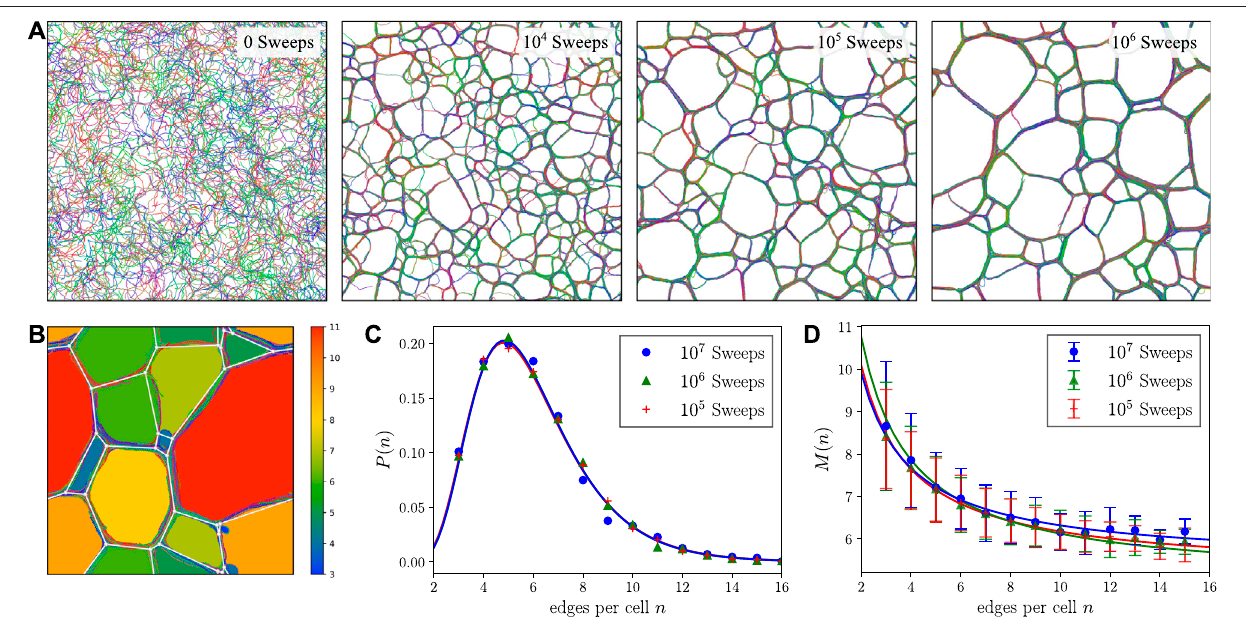
FIGURE 8 | (A) A series of snapshots (after 0, 10 4 , 10 5 , 10 6 sweeps; in a sweep, each sphere is moved once on average); demonstrating coarsening. The snapshots are taken from a simulation of M (cid:2) 1000 polymers à N (cid:2) 100 beads in a 400 σ × 400 σ × 10 σ simulation box. The simulation is performed with the following parameters:bendingconstant κ (cid:2) 30 k B T σ ,springconstant k (cid:2) 100 k B T / σ 2 andrestlength b 0 (cid:2) σ ,potentialstrength g (cid:2) 0 . 7 k B T andrange d (cid:2) 0 . 4 σ .Arandomcoloris assigned to each polymer for clarity (B) Example of a simple graph representation (white balls and bonds) as overlay over a network snapshot generated by an automatedproceduretoidentifyvertices(whiteballs)andedges(whitebonds)ofthebundlenetwork.Thecolorofcellscodesforthenumberofenclosingedges.Alldata in Figs. C and D is measured from such graphs. For clarity, we use a comparatively small system (C) Distribution P ( n ) of the number of edges n per cell for different simulation times. The curves are obtained by fi tting log-normal distributions to the data (D) Aboav-Weaire law M ( n ) for different simulation times, which measures the mean edge counts of neighboring cells. Cells with a high number of edges tend to have neighboring cells with fewer edges and vice versa. Error bars represent one standarddeviation.TheAboav-Weairelaw,the fi tsof P ( n ) inCaswellasdirectcomputationofthevariance μ 2 ofthenumberofedgespercellyieldsimilarvalues μ 2 ∼ 5 . 2 for the simulation parameters given in A